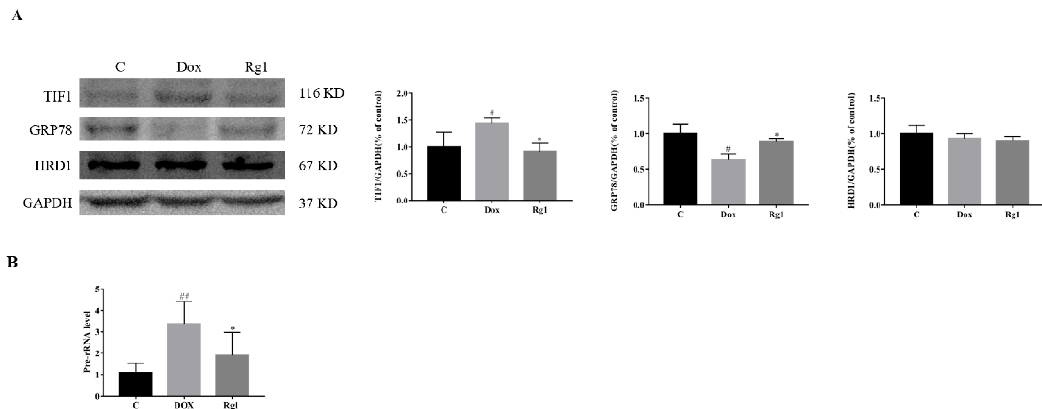
Figure 5. The mechanisms of Rg1 to improve endoplasmic reticulum stress. ( A ) Expression of TIF1, GRP78 and HRD1 protein in mouse heart. ( B ) Expression of Pre-rRNA level in mouse heart, GAPDH was used as the loading control. # p < 0.05, ## p < 0.01 vs C group, * p < 0.05 vs DOX group.